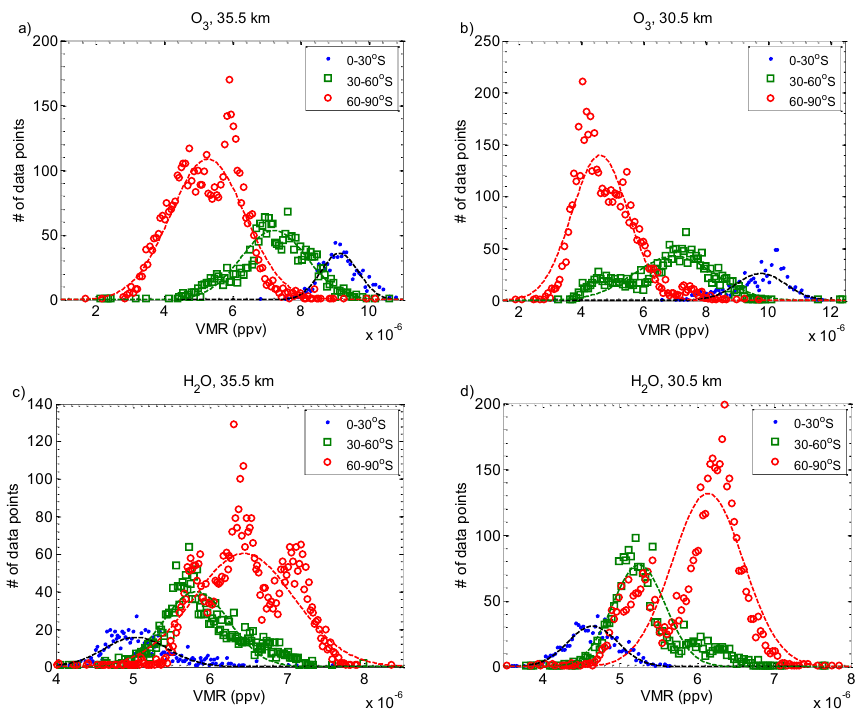
Figure 2. 2004–2013 ACE-FTS VMR distributions for sunset occultations (symbols) in the Southern hemisphere and corresponding best fits to normal distribution (dashed lines): (a) O 3 at 35.5km; (b) O 3 at 30.5km; (c) H 2 O at 35.5km; (d) H 2 O at 30.5km.